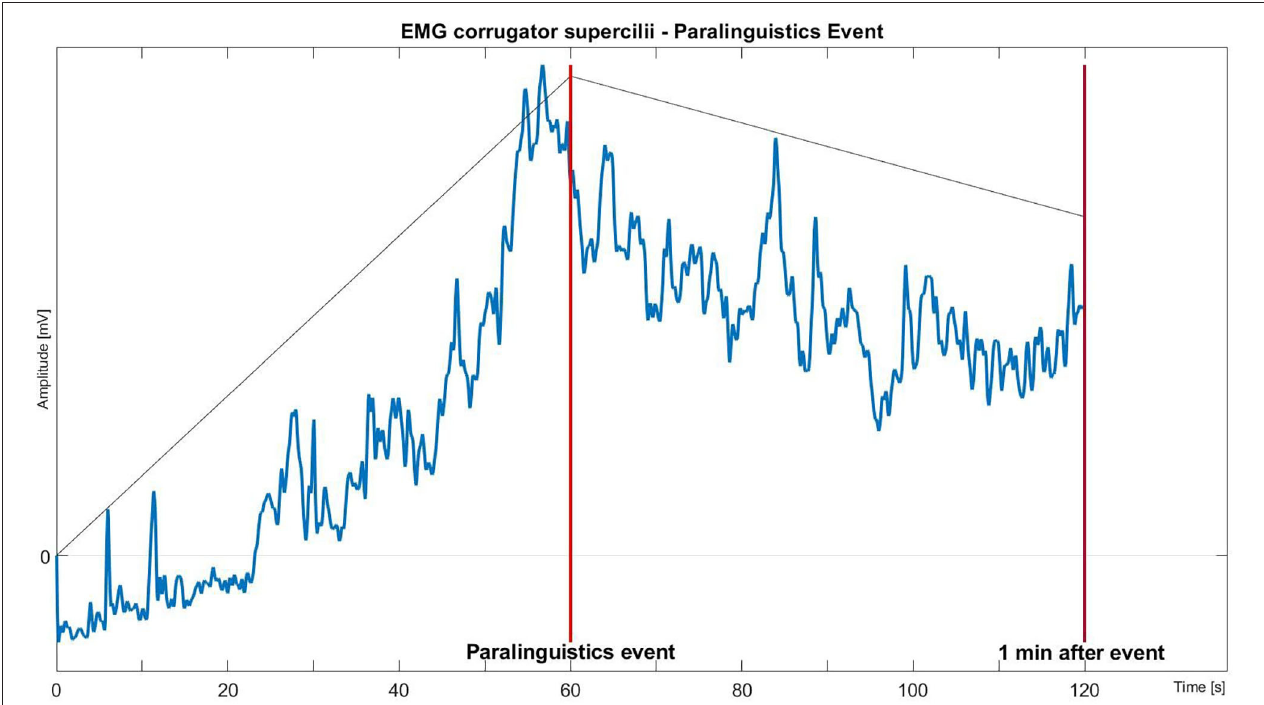
FIGURE 2 | Biosignals of autonomous nervous signals (B-ANS) before one-minute windows (T1: 0–10s, T2: 10–20s, T3: 20–30s, T4: 30–40s, T5: 40–50s, T6: 50–60s) before relevant triggers (“ movement ” or “ paralinguistics ”) were cut out of the signals.